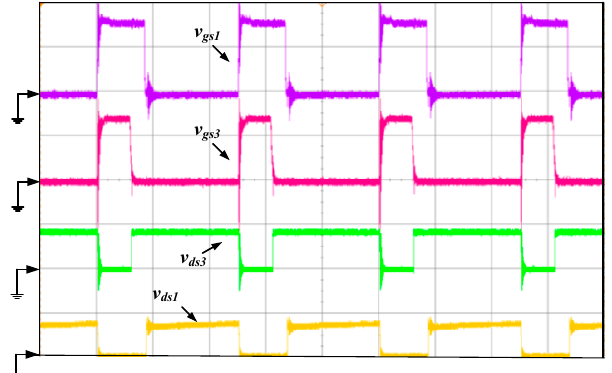
Figure 12. The waveforms of control signals and corresponding input currents at full load under the DIO situation.